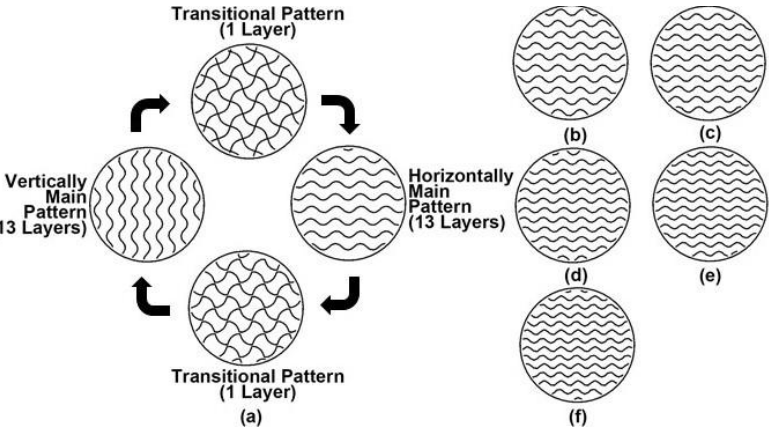
Figure 4. Tracing patterns of gyroid fill with different infill densities. ( a ) complete cycle for 36%; ( b ) horizontal main pattern for 40%; ( c ) horizontal main pattern for 43%; ( d ) horizontal main pattern for 46%; ( e ) horizontal main pattern for 49%; ( f ) horizontal main pattern for 53%.